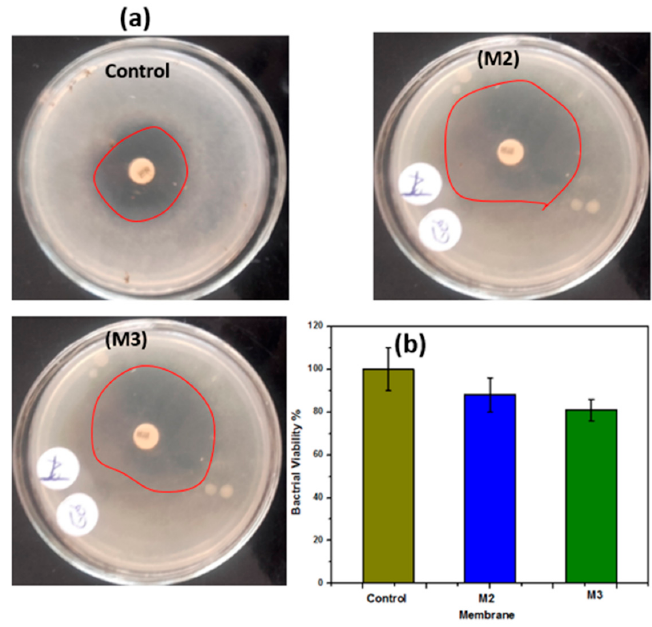
Figure 9. ( a ) Antibacterial properties of the M2 and M3 membranes against E. coli compared to the control agar plate; ( b ) water flux of the different membranes.